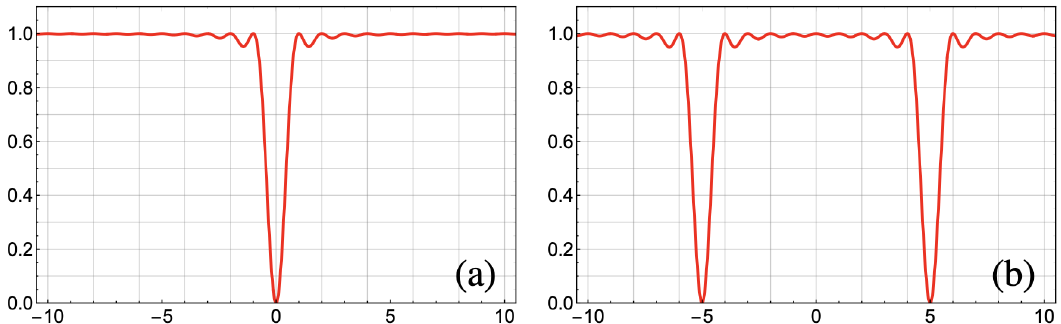
Figure 7. Density profiles in the free fermions. ( a ) density profile of the state of Equation (82) with N = L = 21, and X 1 = 0; ( b ) density profile of the state of Equation (84) with N = L = 21, X 1 = − 5, and X 2 =